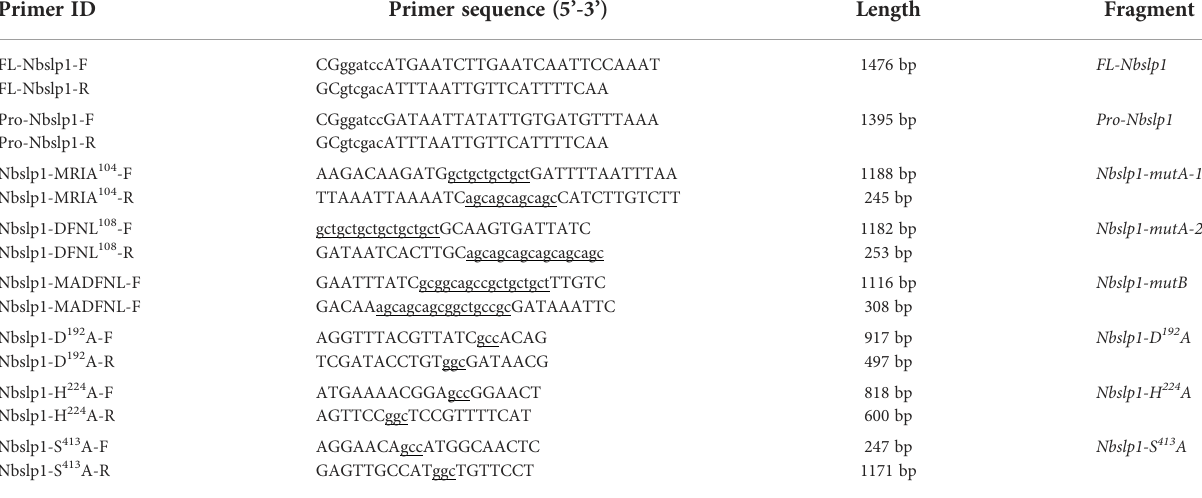
TABLE 1 Primers for Nbslp1 and mutants. Primer